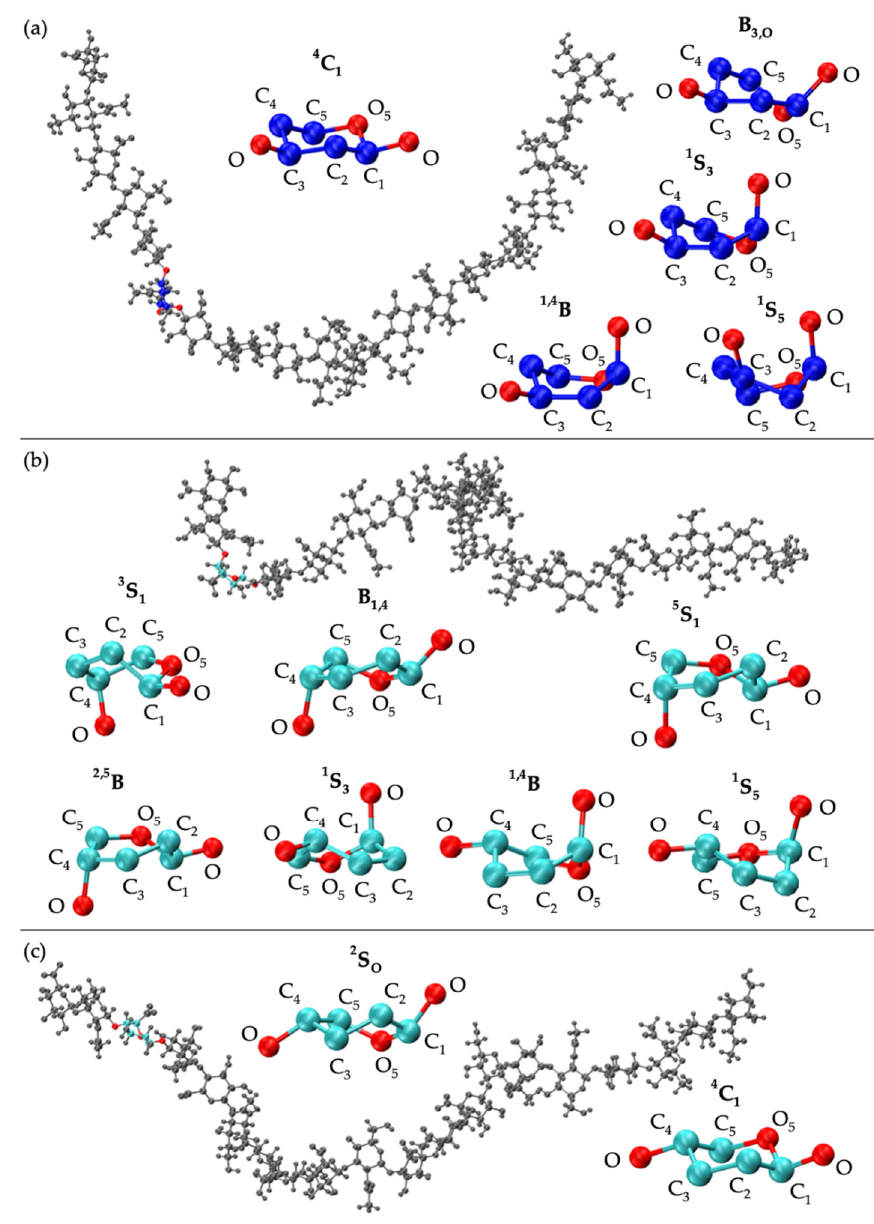
Figure 4. MD-generated hyaluronan conformations: ( a ) 20-mer with a 1,4 B GlcNAc conformer (ring atoms in blue; linkage atoms in red) and 4 C 1 , B 3,O , 1 S 3 , 1,4 B, and 1 S 5 GlcNAc monosaccharide conformations (endocyclic ring atoms and linker oxygen atoms only); ( b ) 20-mer with a 5 S 1 GlcA conformer (ring atoms in cyan; linkage atoms in red) and 3 S 1 , B 1,4 , 5 S 1 , 2,5 B, 1 S 3 , 1,4 B, and 1 S 5 GlcA monosaccharide conformations (endocyclic ring atoms and linker oxygen atoms only); ( c ) 20-mer with a 2 S O GlcA conformer (ring atoms in cyan; linkage atoms in red) and 4 C 1 and 2 S O GlcA monosaccharide conformations (endocyclic ring atoms and linker oxygen atoms only); in each 20-mer snapshot, all gray rings are in 4 C 1 conformations.